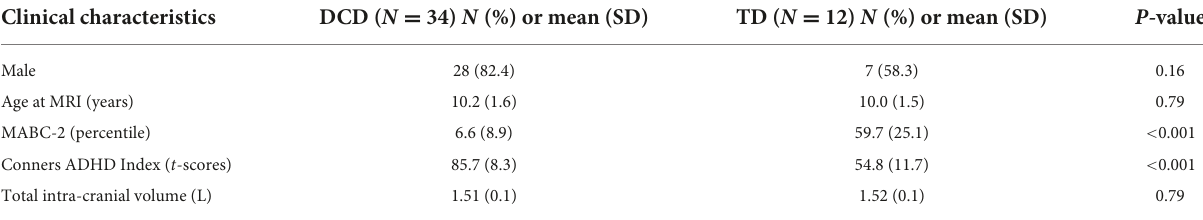
TABLE 1 Description of cohort ( N =